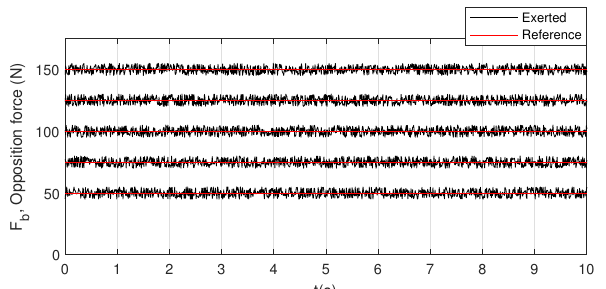
Figure 11. Examples of five experiments of opposition force